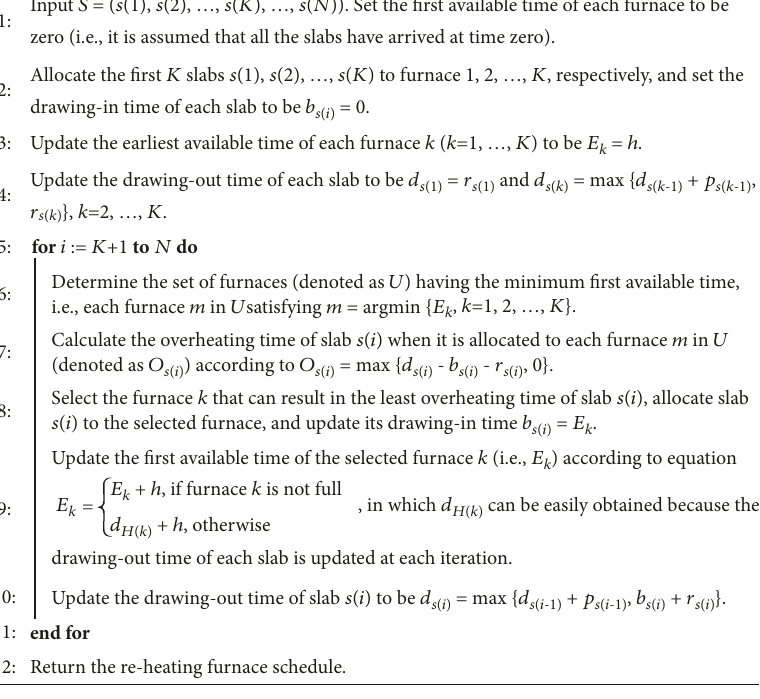
Figure 4: Procedure of the decoding